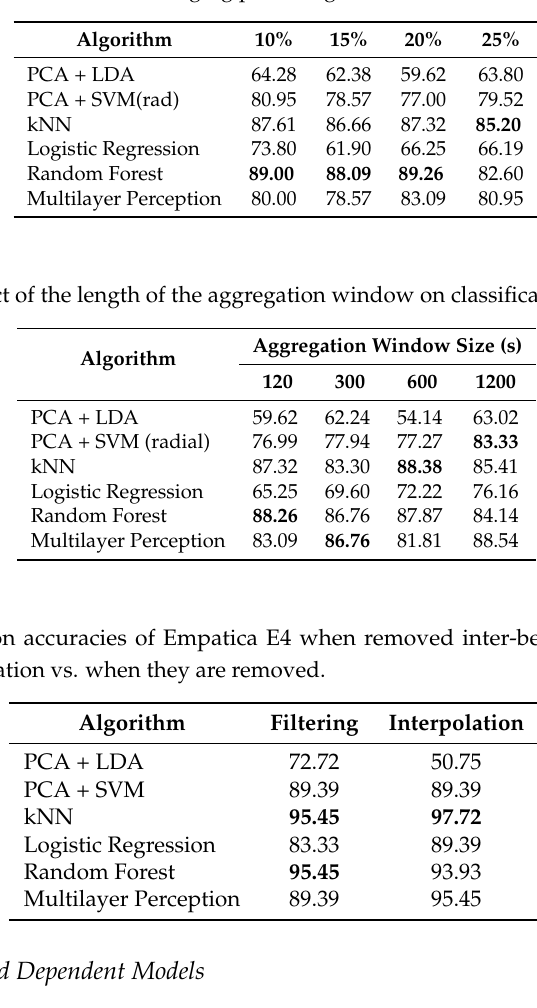
Table 9. Classification accuracies vs. changing percentage based artifact detection and filtering rules.